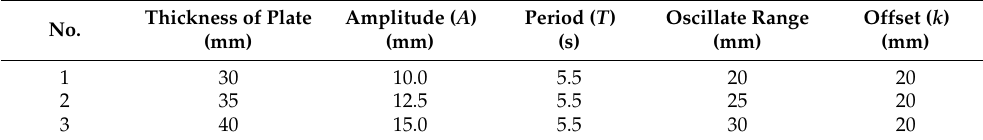
Table 5. Sinusoidal path parameters of welding heat source.